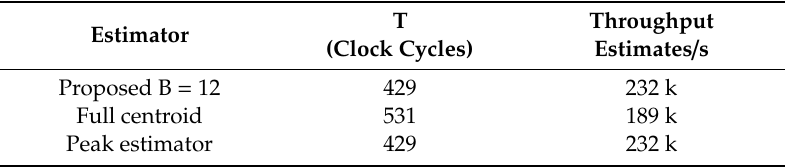
Table 5. Throughput of the frequency estimation for L =